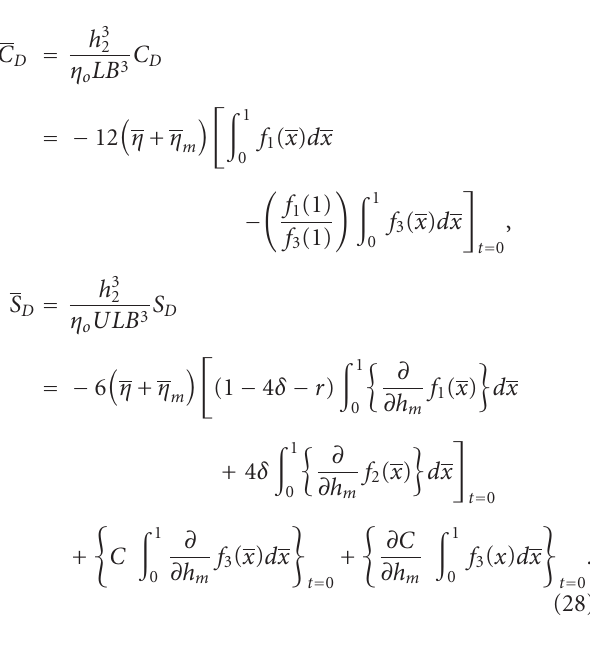
(i) α : 0–10, (ii) φ : 0–1.0, (iii) δ : 0–0.5, and (iv) r :